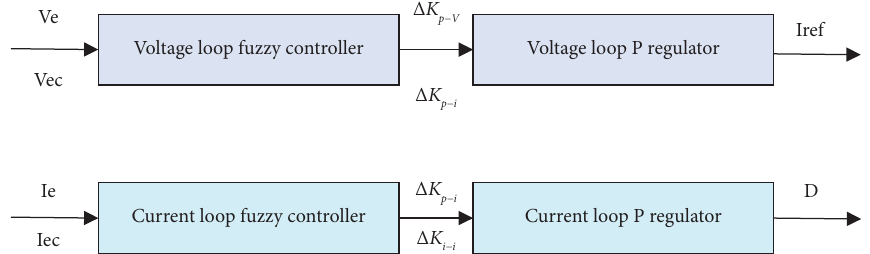
Figure 8: Input and output diagram of a voltage loop and current loop fuzzy control. Table 1: Fuzzy rules of Δ Kp.